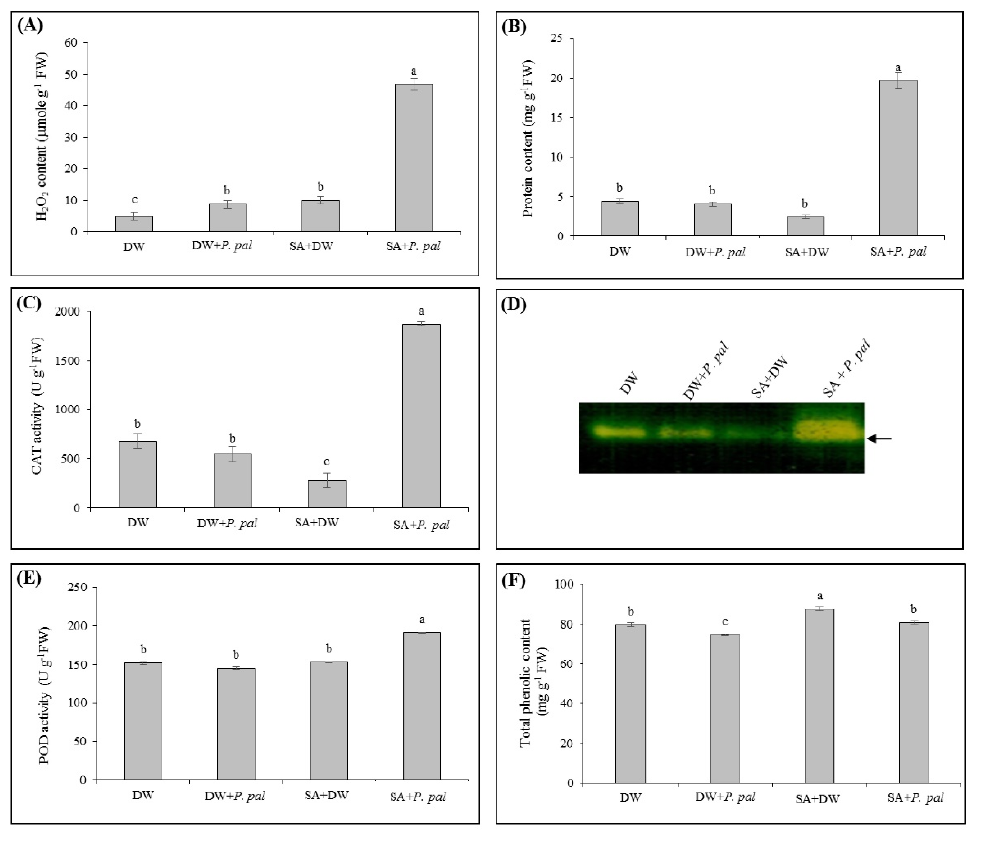
Figure 2. Effect of exogenous SA pretreatment on H 2 O 2 content, total protein content, CAT and POD activities and total phenolic content in rubber tree leaves after inoculation with P. palmivora ( P. pal ). The leaves of rubber tree seedlings were sprayed with either distilled water (DW) or 5 mM SA. After 1 day of the treatment, leaves were subsequently treated with either DW or P. palmivora zoospore suspensions at 1 × 10 5 zoospores mL − 1 . After 4 dpi, the leaf samples were collected for determining ( A ) H 2 O 2 content; ( B ) total protein content; ( C ) CAT activity; ( D ) CAT activity staining; ( E ) POD activity; and ( F ) total phenolic content. The columns and vertical bars represent mean ± standard errors (SE) of three independent replicates of 10 seedlings. Different letters represent significant differences, according to Tukey’s HSD test at p ≤ 0.05. Arrows indicate the position of CAT activity band.